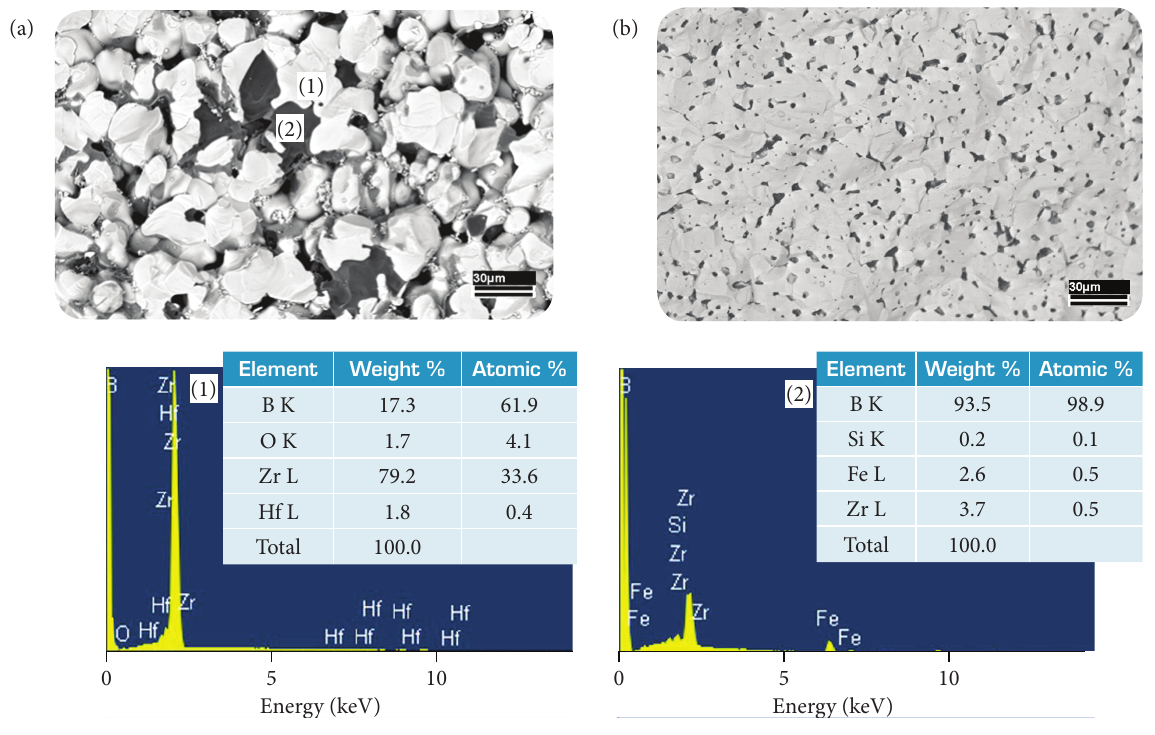
Figure 6. SEM images of sintered ZrB